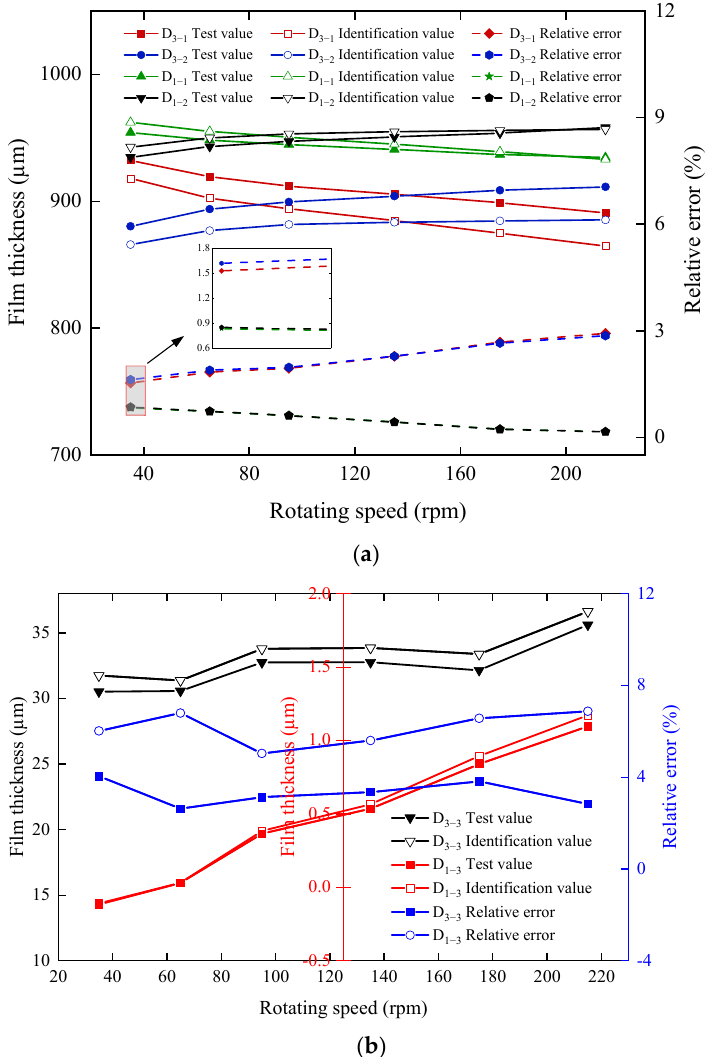
Figure 7. Comparison of test and identification film ‐ thickness results: ( a ) Data of #1 and #2 sensors in each section and ( b ) data of #3 sensor in each section.